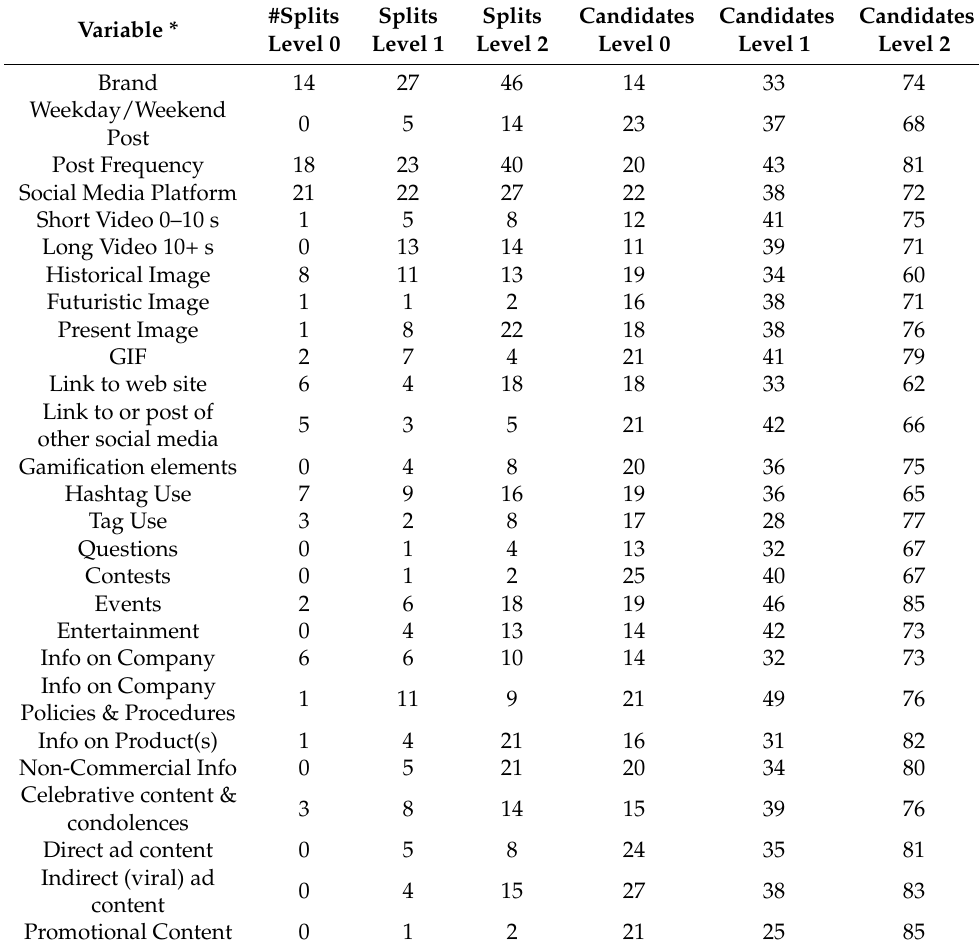
Table 3. Random forest decision tree attribute selection